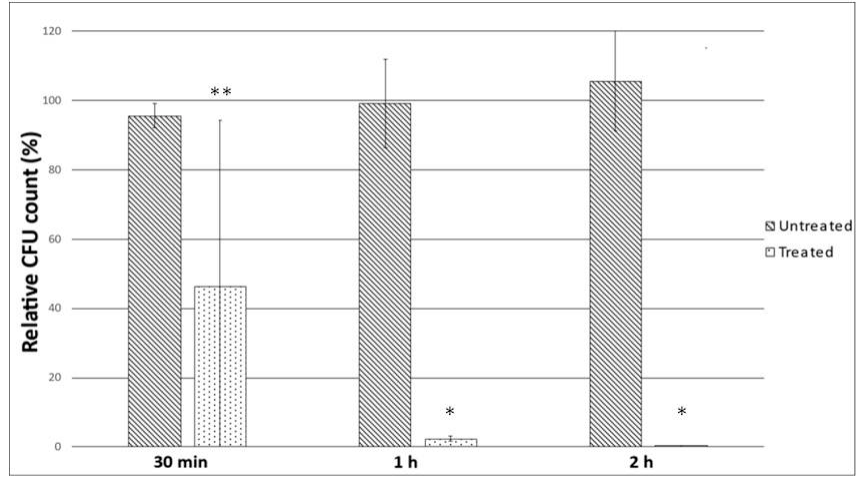
Figure 3. Results of mucin penetration assay showing time required for HerbELICO ® essential oils mixture to penetrate mucin layer and kill off H. pylori cells beneath. * statistically different from untreated group (control) ( p < 0.01); ** statistically not different from untreated group (control) ( p > 0.01).